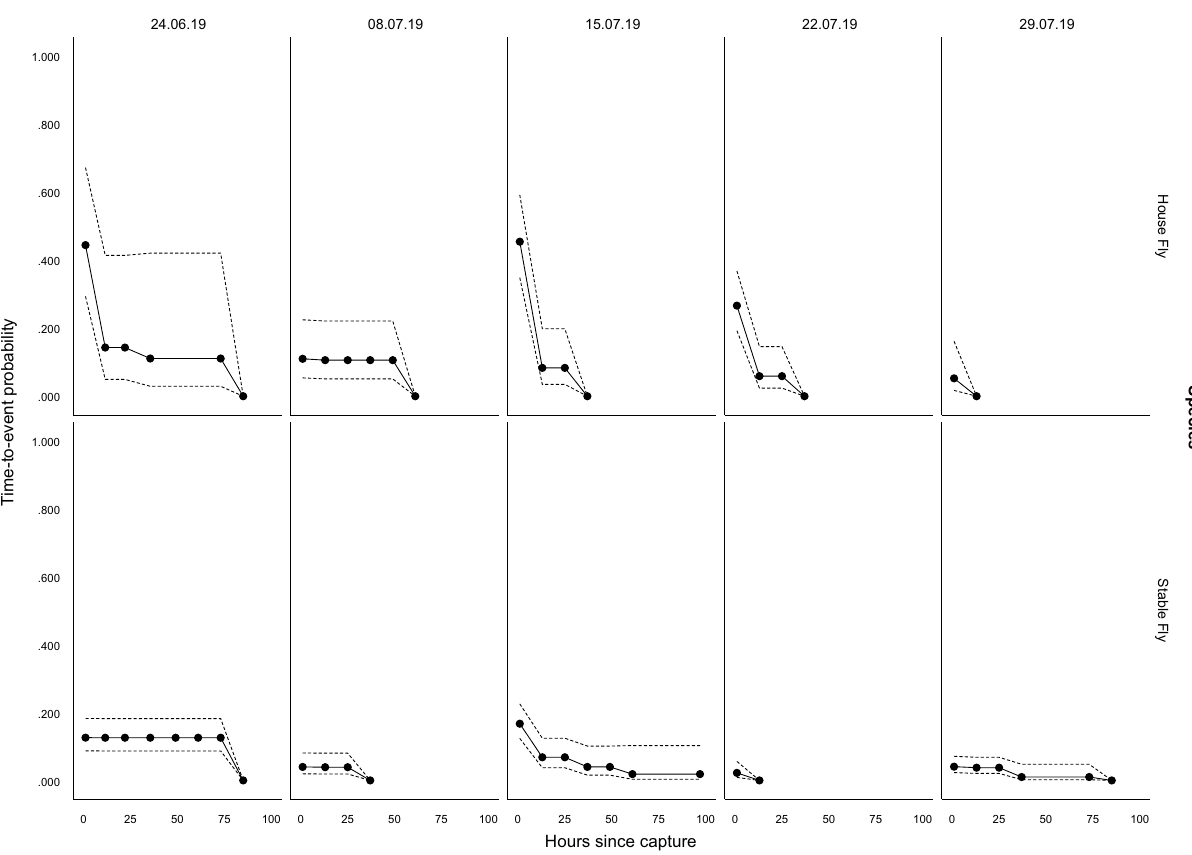
Figure 2. Kaplan–Meier time-to-event curves with confidence intervals (95%) for house- and stable flies for 5 different collection dates and the following 96 h of externally present live LA-MRSA bacteria. As a result of the censoring in the time-to-event model, estimations of the time-to-event probabilities in-between our sampling points are also